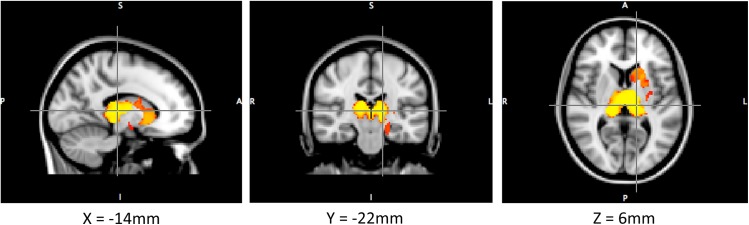
Voxel-based morphometry of the multiple sclerosis group compared to controls.Showed relative atrophy of the thalami and caudate nuclei.